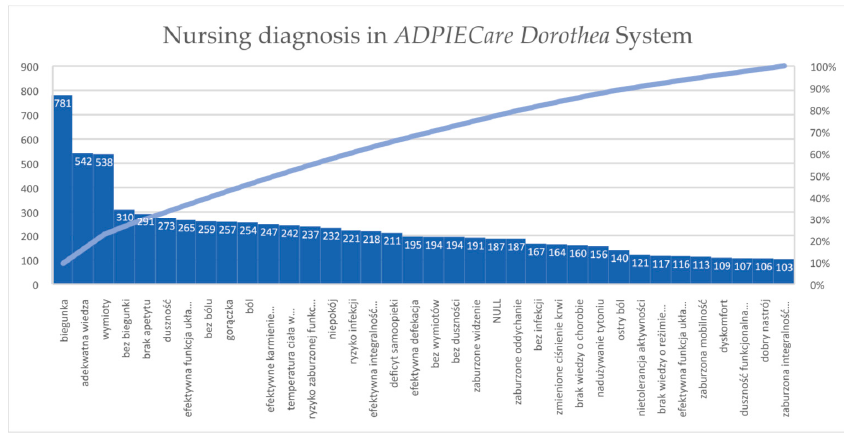
Figure 6. The most frequently selected nursing diagnoses assessing patients in ADPIECare Dorothea made by students in the years 2017–2021 from a range exceeding 100 care plans for a given